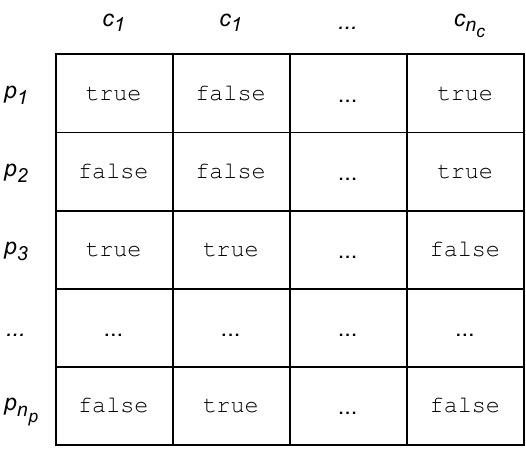
Figure 2. Professors’ preferences matrix.